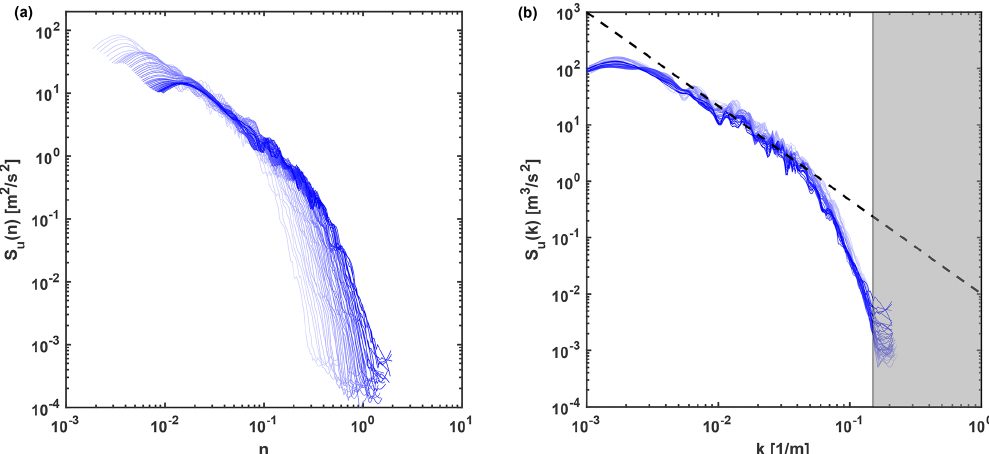
Figure 8. Velocity spectra for the SLTEST dataset at different heights: (a) spectra as a function of the reduced frequency, n , and (b) spectra as a function of the wavenumber, k . Line color is darker with increasing height. The black dashed line represents the − 5 / 3 slope. In (b) , the shaded area covers the noisy part of the velocity